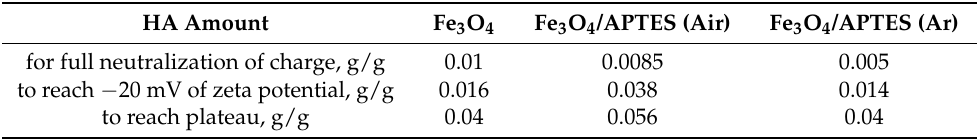
Table 2. Amount of HA needed to reach the changes in surface charge for the Fe 3 O 4 -APTES samples (pH ∼ 5 and KCl = 0.01 M). HA Amount for full neutralization of charge, g/g 0.01 0.0085 to reach − 20 mV of zeta potential, g/g 0.016 to reach plateau,